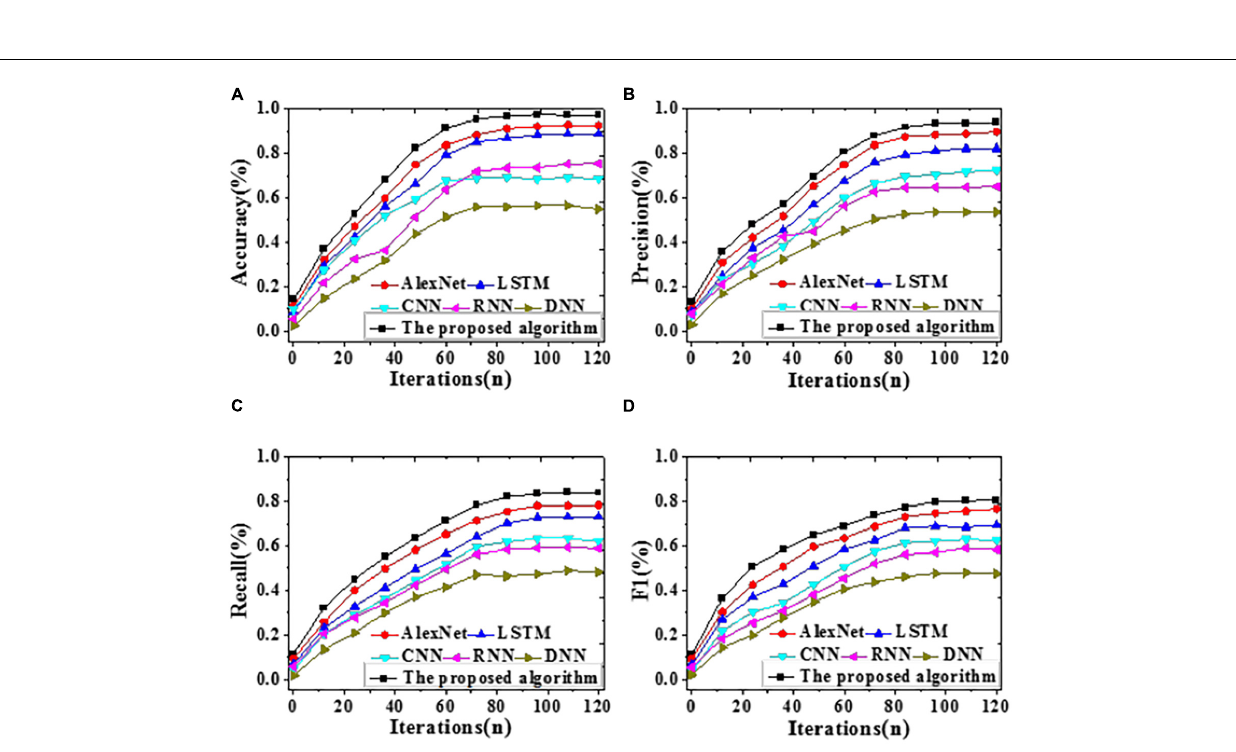
Frontiers in Psychology |